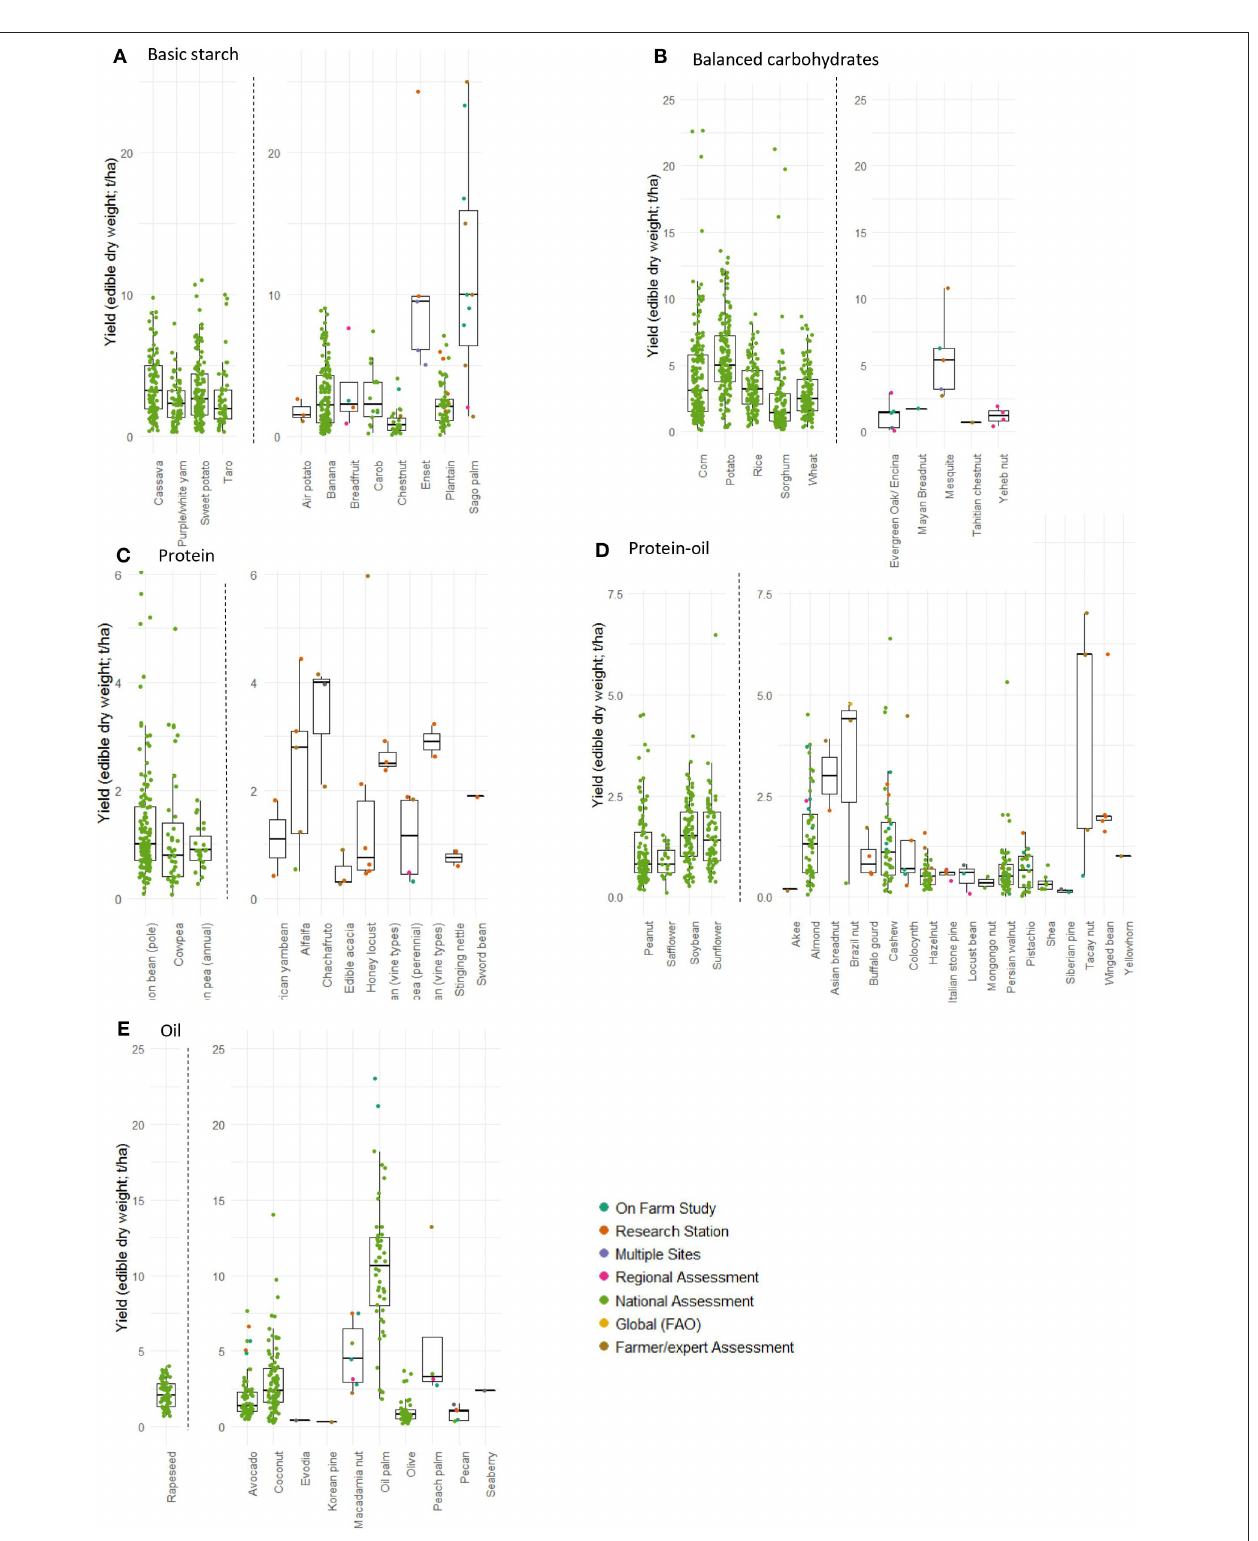
FIGURE 1 | Yields of perennial staple crops. Left panels contain annual crops, right panels contain perennial crops. Each point represents one data point (t/ha of dry, edible portion) from the literature, color coded by data type (see methods for full reference list). Box plots show the mean (line through box), 25th and 75th percentile (top and bottom of box), largest and smallest value within 1.5 times of interquartile range (top and bottom of whiskers). Green points (National Assessments) are mainly FAO data. (A) Basic starch crops; (B) balanced carbohydrate crops; (C) protein crops; (D) protein-oil crops; (E) oil crops.